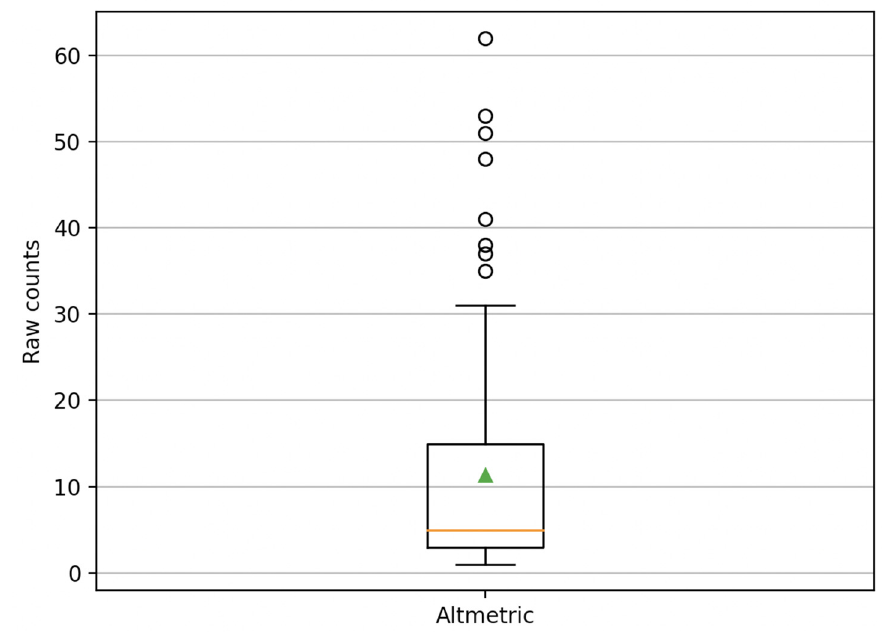
Figure 9. JOHD/RDJ data papers: Altmetric scores.